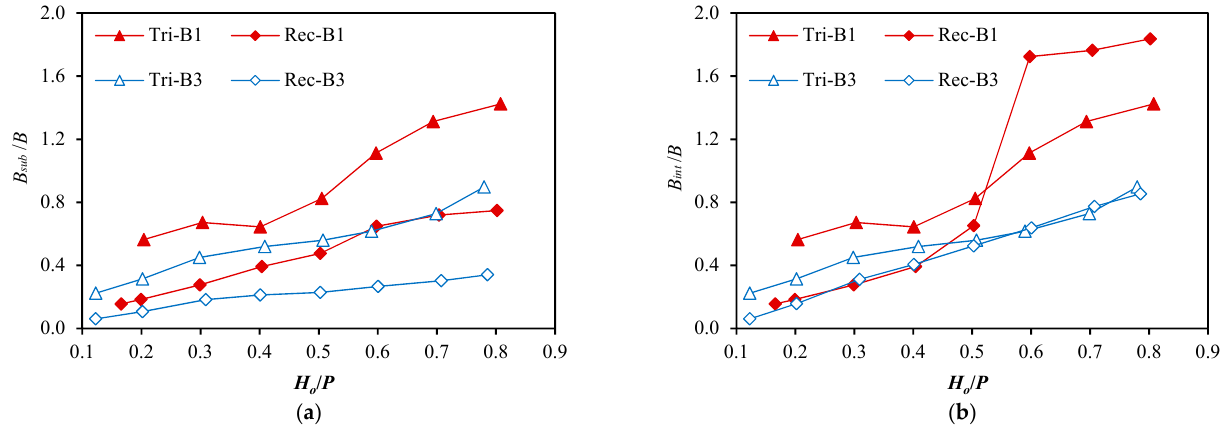
Figure 16. Nappe interference characteristics: ( a ) Rec-B1, H o / P = 0.30; ( b ) Tra-B2, H o / P = 0.30; ( c ) Tri-B2, H o / P = 0.49;( water surface profile in outlet key centerline; water surface profile in inlet key centerline).